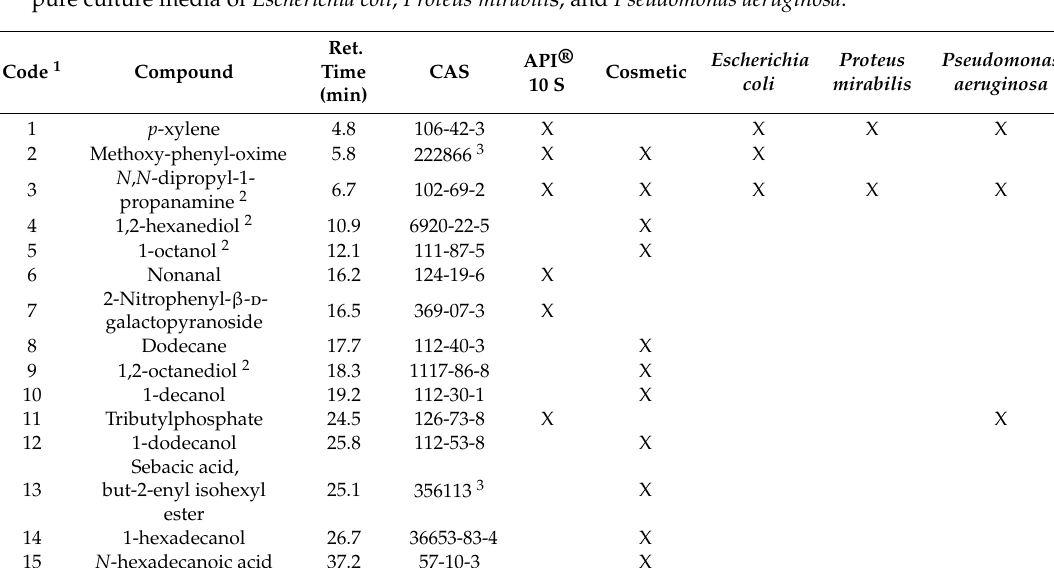
Figure 5. Obtained SPME-GC-MS chromatograms for the blanks: API ® 10 S components, cosmetic, and pure culture media of the 3 studied microorganisms. Table 1. Identified compounds by SPME-GC-MS in the blanks: API ® 10 S components, cosmetic,